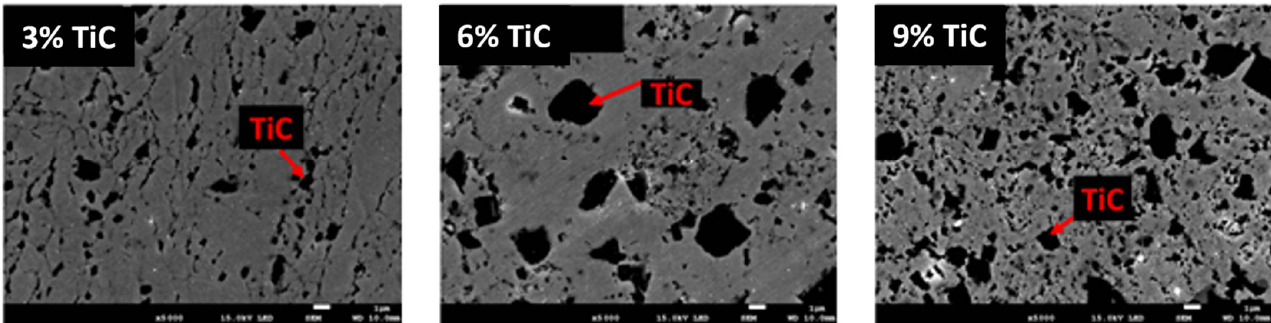
Figure 5. SEM of Cu/TiC nanocomposite with TiC percentage of 3, 6, and 9% prepared using spark plasma sintered route.